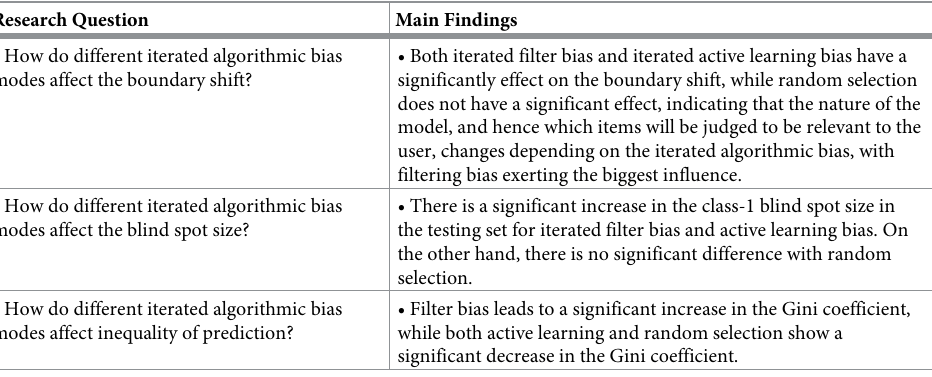
Table 20. Summary of research question (RQs) and findings for real